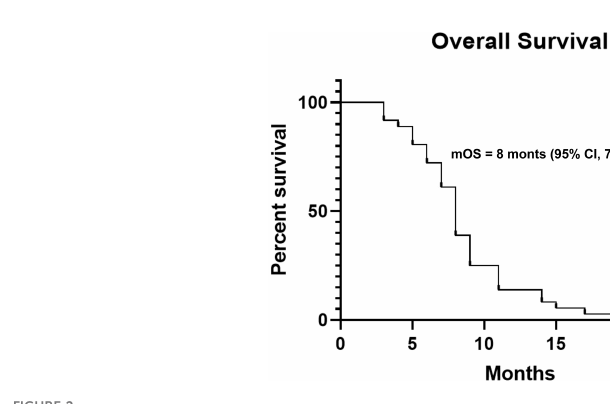
FIGURE 2 Kaplan-Meier curves for OS and